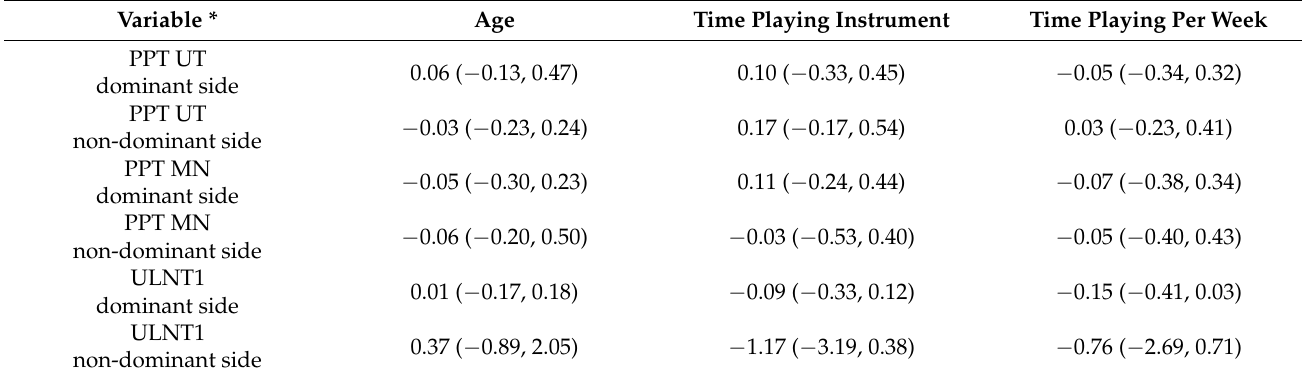
Figure 1. Diagram of the simple mediation model constructed. Table 4. Indirect effects of pain on the pressure pain threshold and neural tension test through mediator variables.